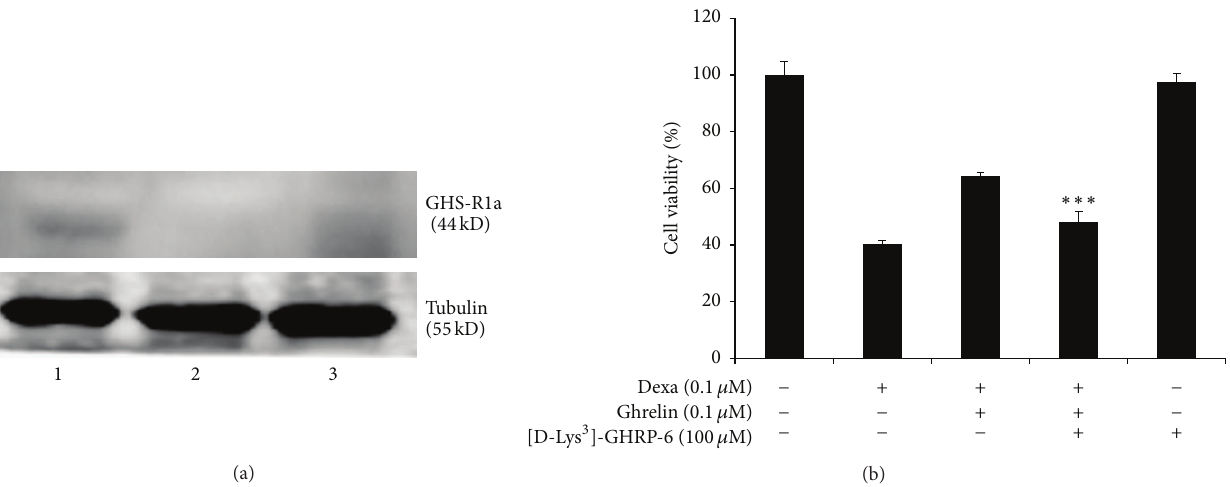
Figure 4: The protective effect of ghrelin on apoptosis of INS-1 after dexamethasone treatment is mediated via the ghrelin receptor, GHS-R1a. (a) The expression of ghrelin receptor, GHS-R1a, was determined by western blot in rat INS-1 cells. Lane 1: rat hypothalamus, lane 2: rat BRL3A cells, and lane 3: rat INS-1 cells. (b) INS-1 cells were pretreated with control or ghrelin (0.1 𝜇 M) for 1h before dexamethasone treatment. The cells were also preincubated with PBS control or ghrelin receptor antagonist, [D-Lys 3 ]-GHRP-6 (100 𝜇 M), 1h before ghrelin treatment. Cell viability was measured at 48h after dexamethasone treatment by MTS assay. Cell survival was expressed as a percentage relative to that in the vehicle control (100%). The data are presented as the mean ± SD. ∗∗∗ 𝑝 < 0.01 versus dexa + ghrelin